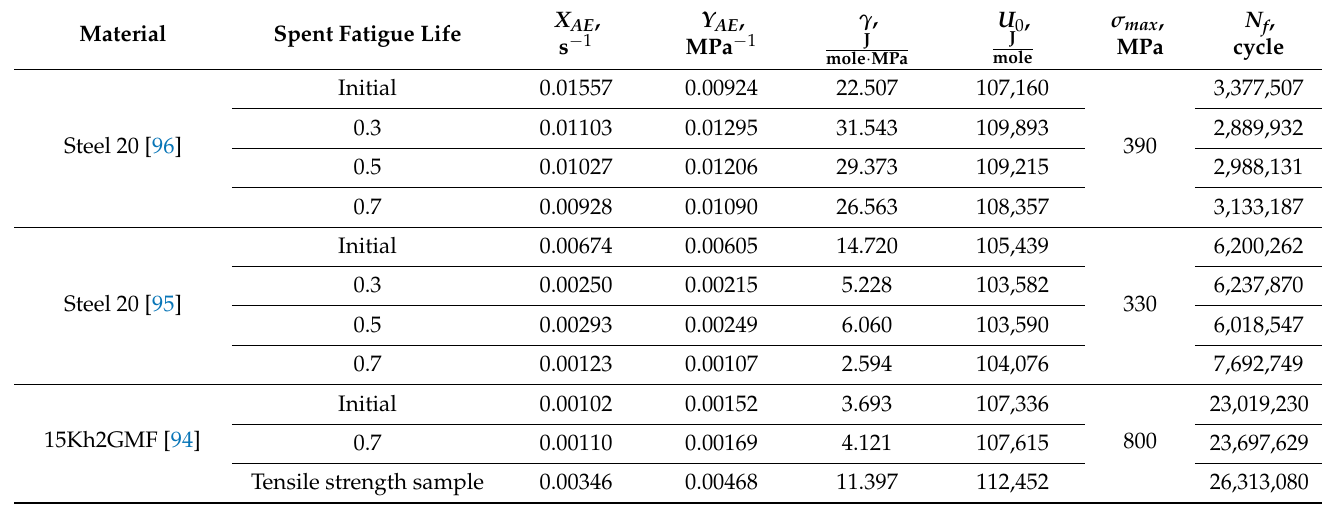
Table 4. Results of fatigue life calculation using concentration-kinetic AE strength indicators.